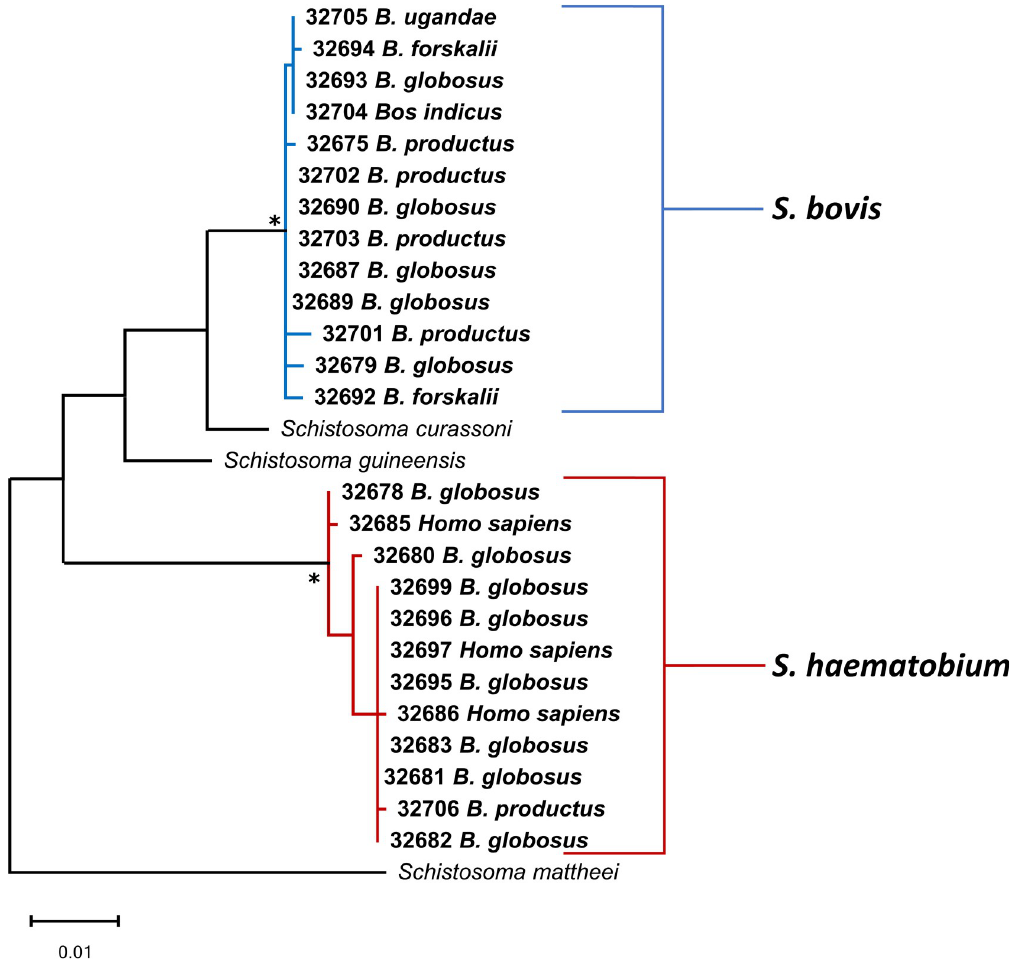
Fig 4. Phylogenetic relationships among Kenyan schistosomes based on concatenated cox1 + ITS sequences. Phylogenetic relationships of schistosomes from this study and from GenBank based on 1166 bp of concatenated cox1 + partial ITS1 + 5.8S + partial ITS2 sequences inferred from ML analysis. Bootstrap values over 95% are indicated by an asterisk. Specimens are listed by MSB:Para: number followed by the host species. Bolded sequences were generated during this study and additional information for specimens can be found in Table